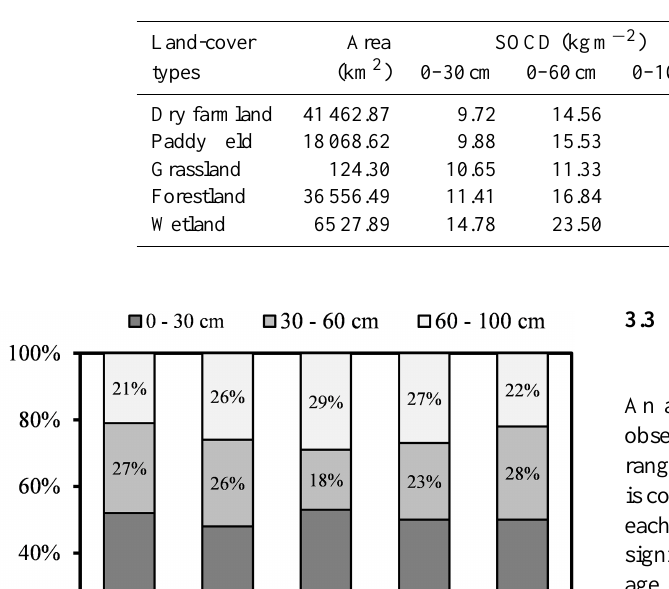
Table 1. SOCD and SOC storage for different land-cover types in the Sanjiang Plain.